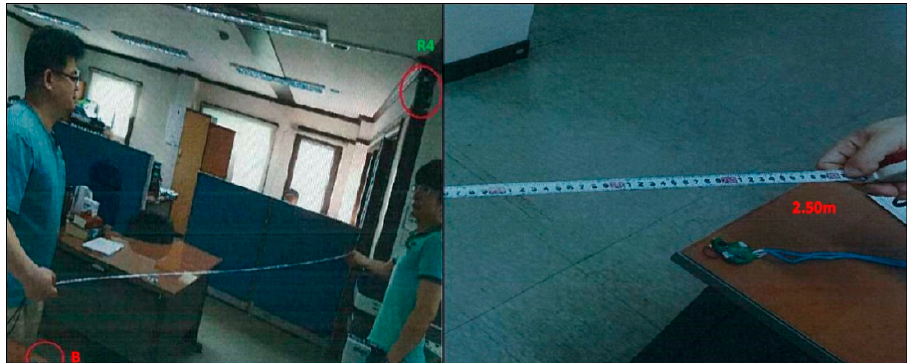
Figure 23. Location B and R4, and real distance between B and R4.